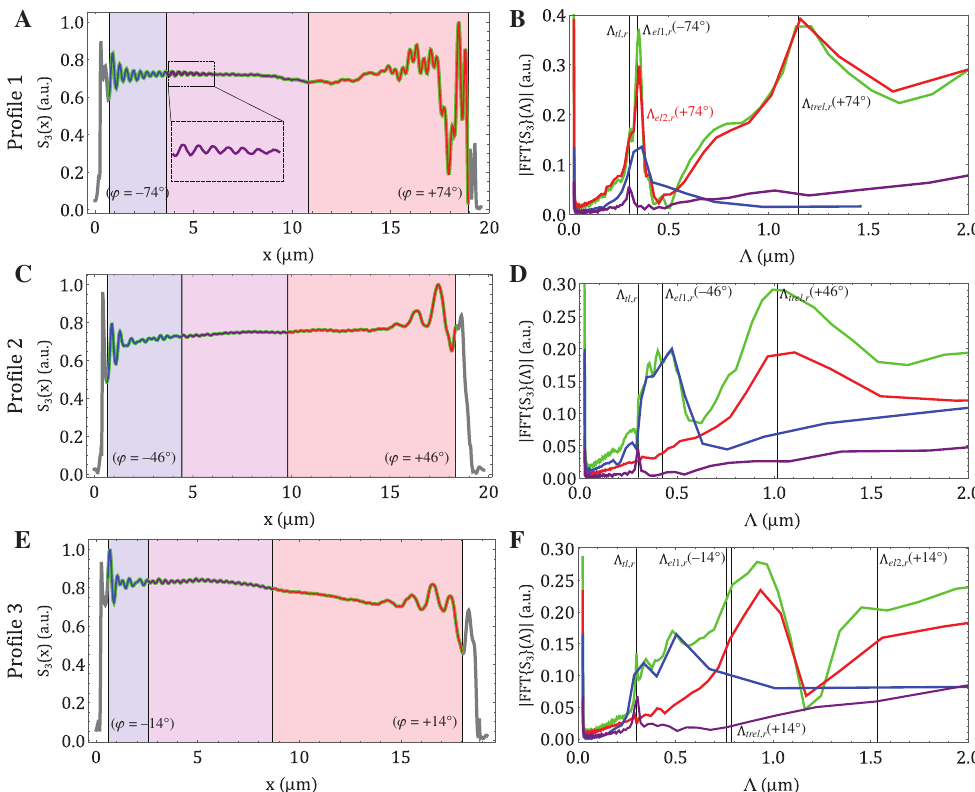
Figure 5: Profiles and corresponding FFTs from the s-SNOM scan at 633 nm shown in Figure 4B. (A) profile 1, (B) corresponding FFT, (C) profile 2, (D) corresponding FFT, (E) profile 3 and (F) corresponding